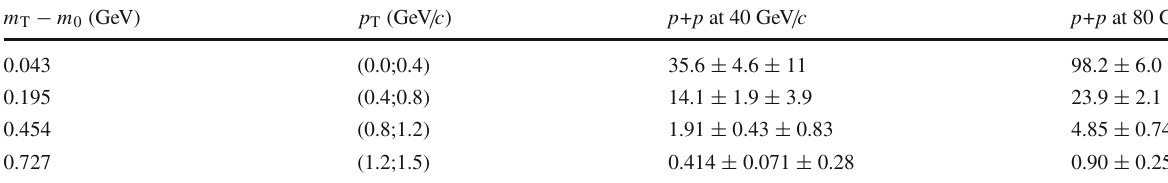
Table 6 The numerical values of double-differential yields 1 80 GeV / c data); the values of m T − m 0 specify the bin centers. The first uncertainty is statistical, while the second one is systematic